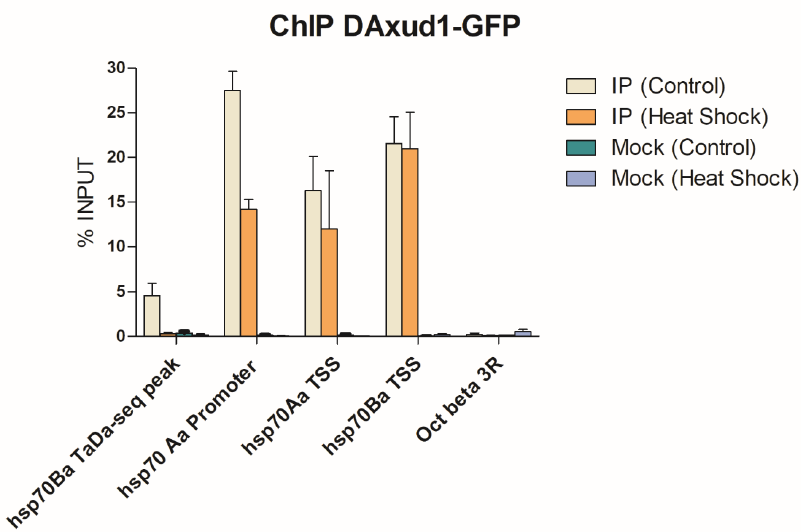
Figure 3. DAxud1-GFP chromatin immunoprecipitation (ChIP). Assays for different loci were per- formed under control conditions (25 °C) and heat shock (37 °C for 20 min). The mock consisted of chromatin immunoprecipitation with Dynabeads only.